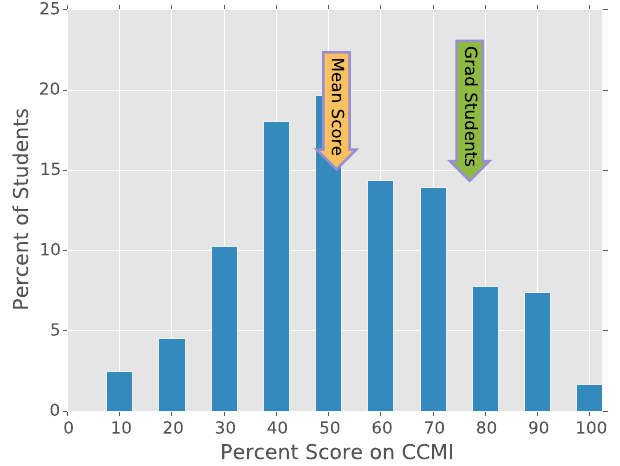
FIG. 5. A histogram of student post-test scores on the CCMI is presented ( N ¼ 462 ; CU and other institutions). The average score for students taking the CCMI is indicated (orange arrow): 49 . 0% (cid:3) 1 . 0% as well as the performance by first-year physics graduate students at CU Boulder (green arrow): 74 . 5% (cid:3) 3 . 4% ( N ¼ 5 ).